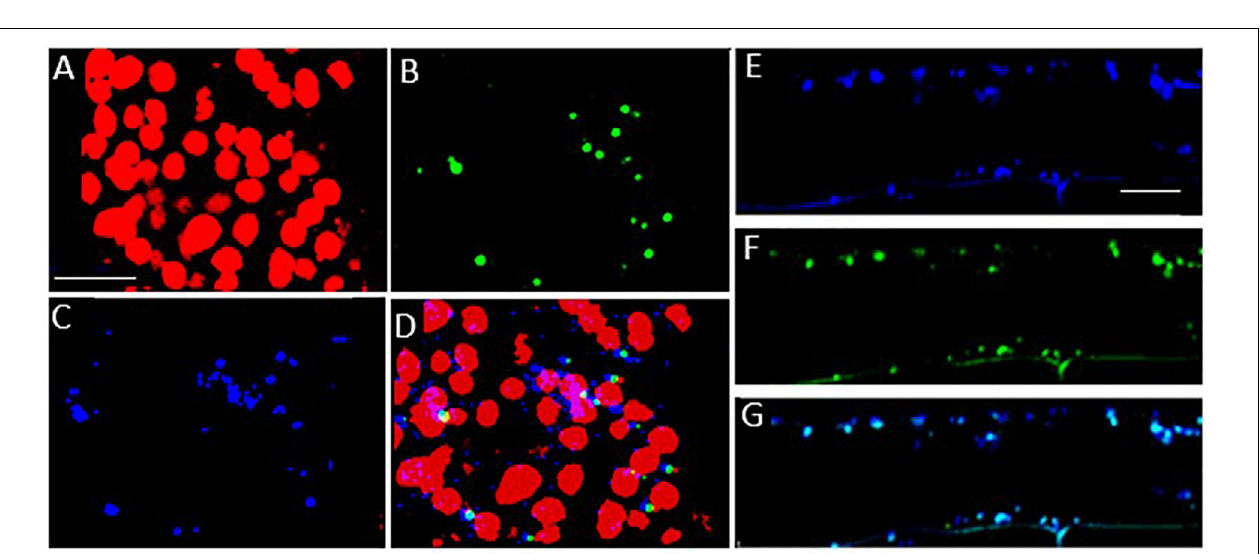
FIGURE 7 | A comparison of the light saturation curves for photosynthesis (A,B) and stomatal conductance (C,D) in wild type barley plants (WT), transgenic lines expressing the Arabidopsis LEA 5 sequence (lines 9, 10, and 11) and empty vector (EV) controls. Plants were grown for either 14 days under well-watered conditions (A,C) or for 7 days under well-watered conditions followed by 7 days without watering (B,D) . Asterisks indicate significant differences between the transgenic lines and control as estimated by the Student’s t -test (** p < 0.01).